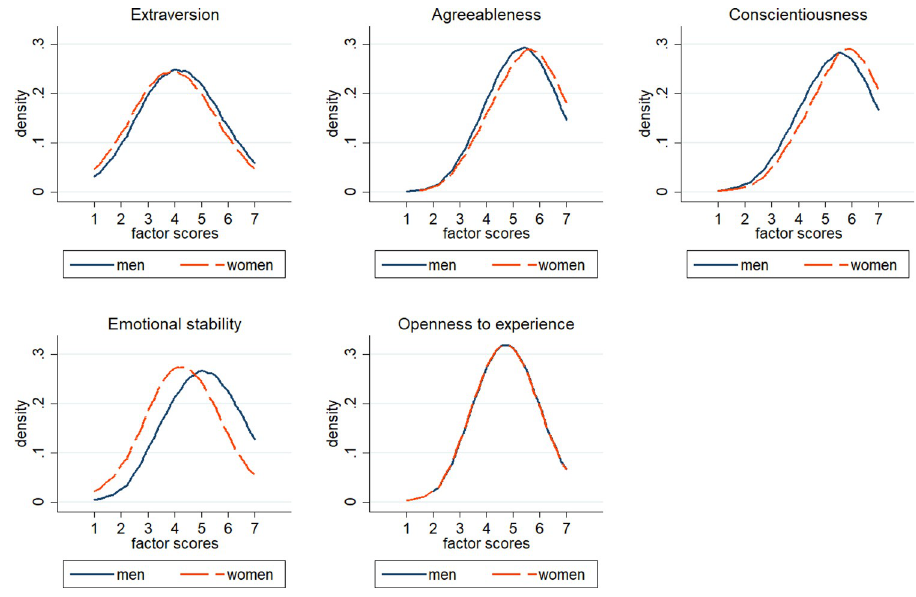
Fig 1. Density distribution of the Big Five trait scores by